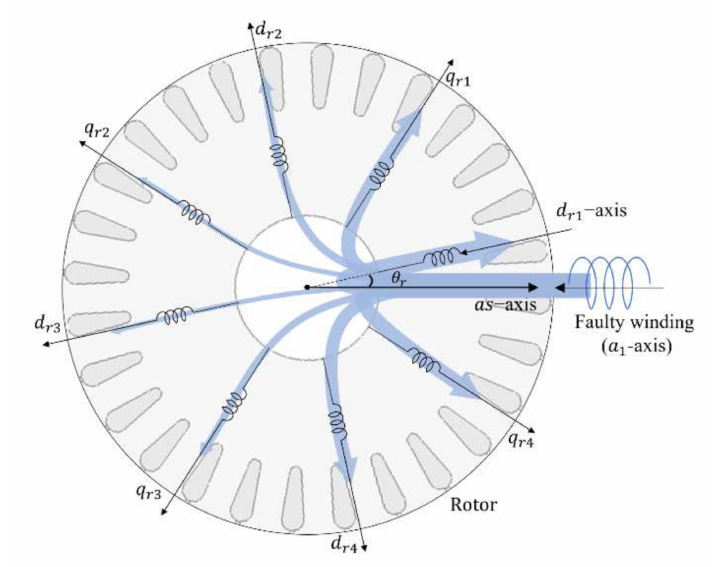
Figure 3. Coupled flux linkage by the faulty